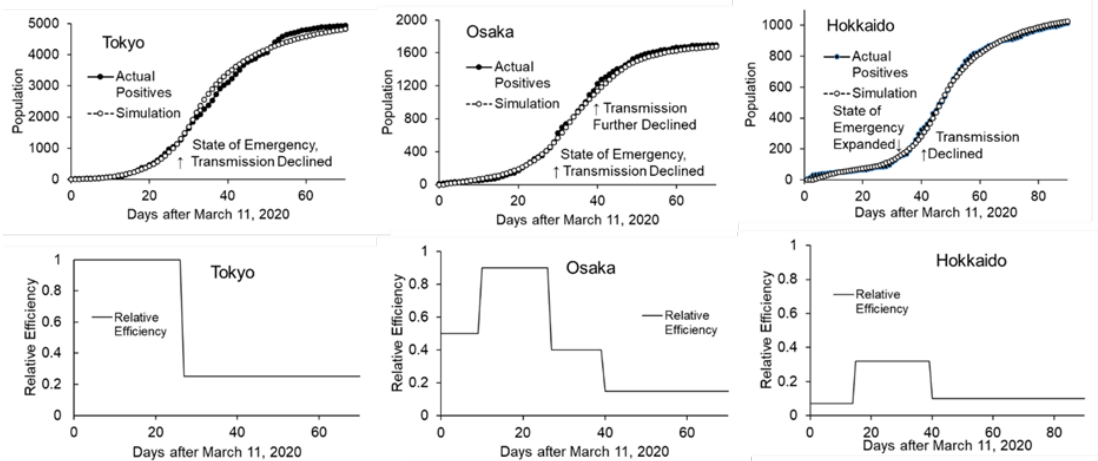
Figure 5. Actual and simulated confirmed positives in 3 regions ( upper ) and estimated transmission efficiencies (expressed as relative to efficiency derived from natural reproduction rate, lower ) are shown. The periods with maximum transmission efficiency in each region were considered as the baseline of outbreak.